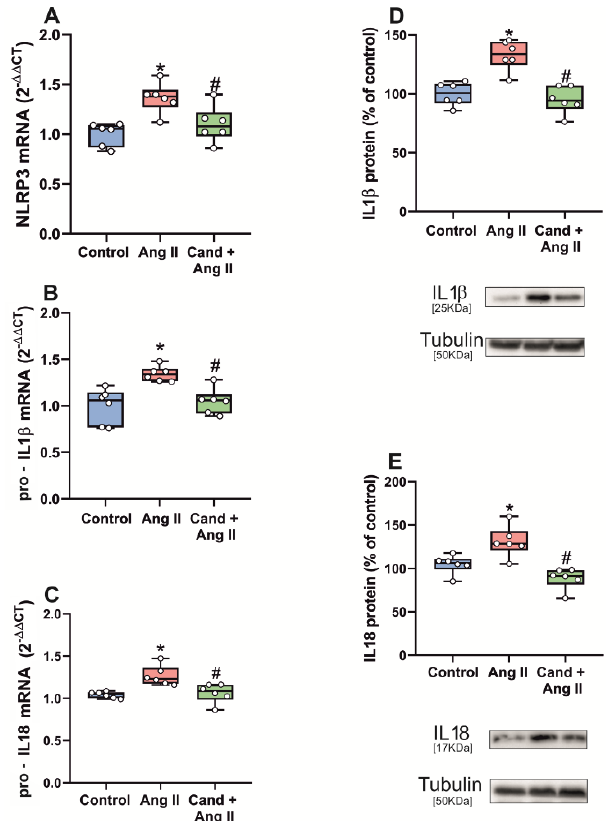
Figure 6. qRT-PCR and WB analysis of expression of NLRP3 inflammasome markers in substantia nigra of rats intraventricularly injected with Angiotensin II (AngII). mRNA expression of NLRP3, pro-IL1 β and pro-IL18 inflammasome markers ( A – C ) and protein expression of IL1 β and IL18 ( D , E ) significantly increased in the substantia nigra vs. non-injected rats. Treatment of rats with candesartan significantly prevented the AngII-induced upregulation of inflammasome markers ( A – E ). To determine the relative mRNA expression of each gene of interest vs. the β -Actin housekeeping transcripts, we used the comparative Ct values method (2 − ∆∆ Ct ). Protein expression was determined relative to the α -tubulin band value and normalized to the control values (100%). Data distribution is shown using box plots with boxes representing the Interquartile range (IQR) and the median and whiskers representing the maximum value (upper whisker) and the minimum (lower whisker). * p < 0.05 relative to control rats; # p < 0.05 relative to AngII-treated rats.